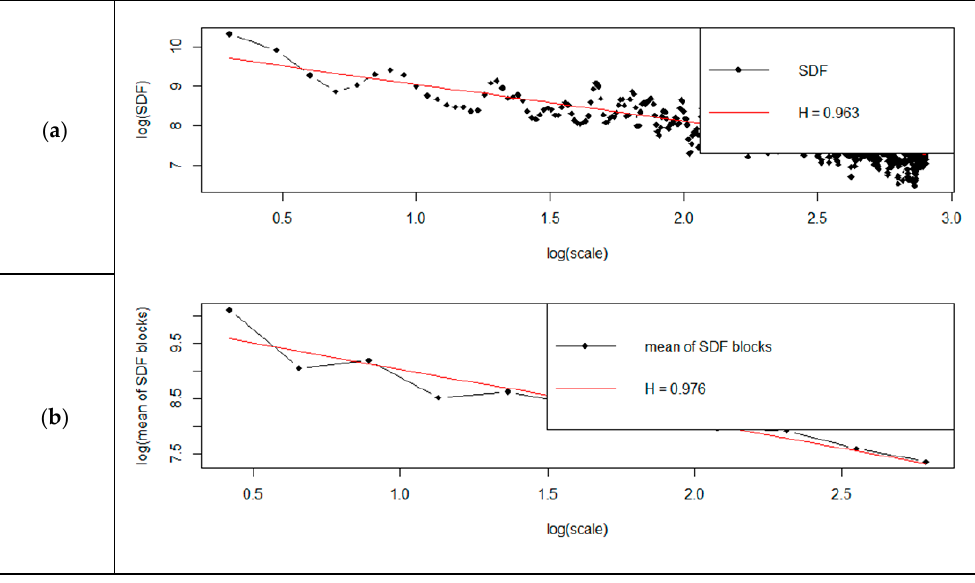
Figure 6. Spectral regression graph by the lag window: ( a ) the standard method, ( b ) the smoothed